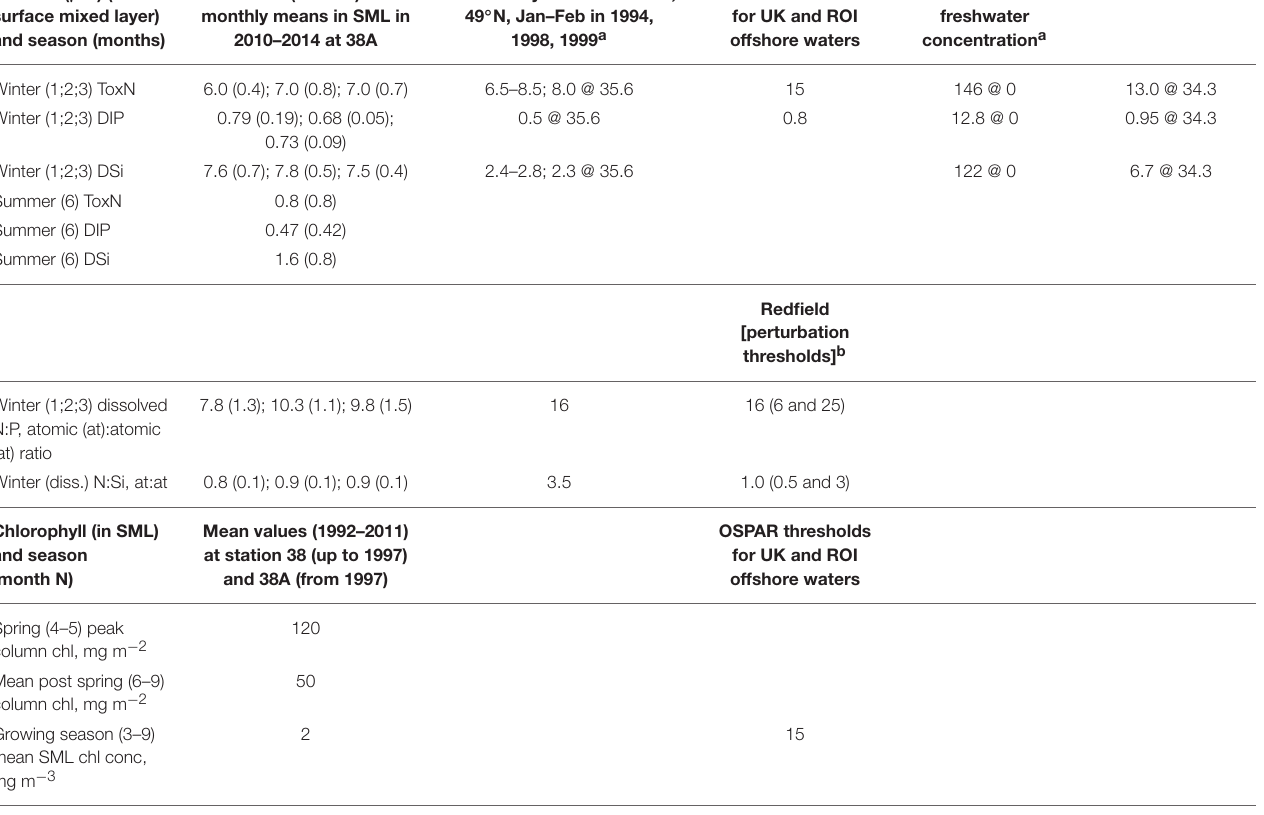
OSPAR thresholds for UK and ROI